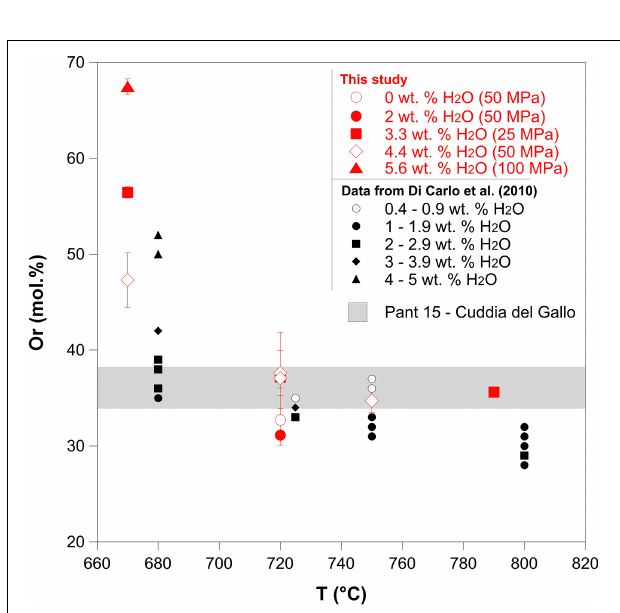
FIGURE 7 | Orthoclase (Or) content of alkali feldspars as a function of the final temperature (T f ) and H 2 O content dissolved in the melt. Data obtained in this study through isobaric cooling experiments are indicated in red. Data obtained from Di Carlo et al. (2010) are indicated in black. The gray shaded band indicates the range of Or contents (34–38 mol%) in natural alkali feldspar crystals obtained from Cuddia del Gallo products